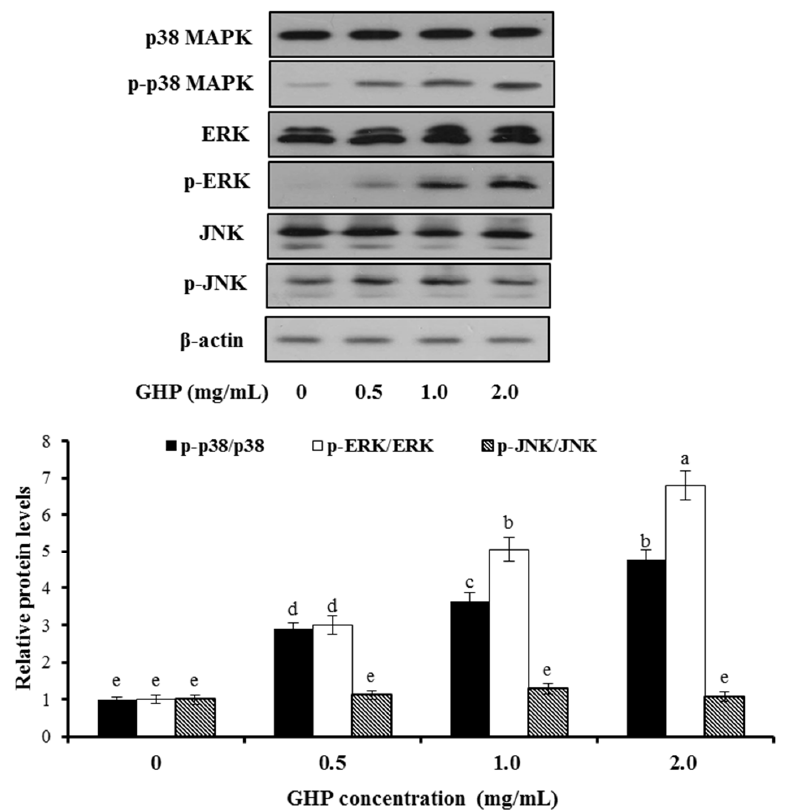
Figure 4. Effects of GHP on phosphorylation and protein expression of ERK1/2, p38 MAPK, and JNK1/2 in HepG2 cells. The activation of the proteins were monitored by Western blot analysis after cells were being treated with GHP (0–2.0 mg/mL) for 1 h. The results are presented as the means ± SD of three independent experiments. Means with different letters are significantly different from each other at p < 0.05.